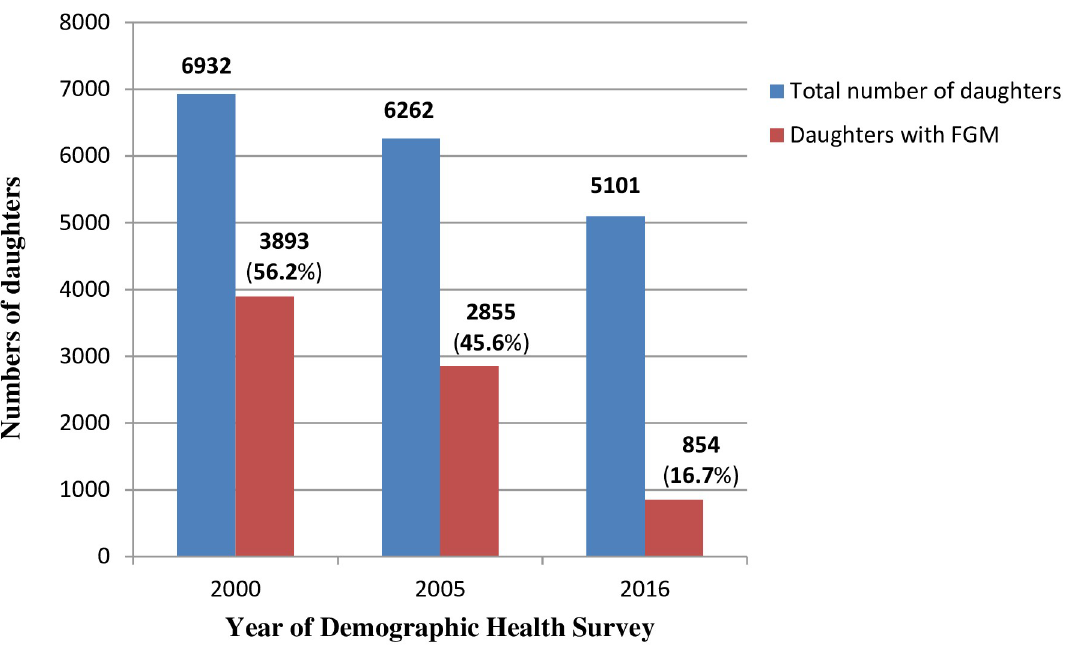
Fig 2. Female genital mutilation (FGM) in daughters born to mothers who had FGM in Ethiopia in 2000, 2005 and 2016.